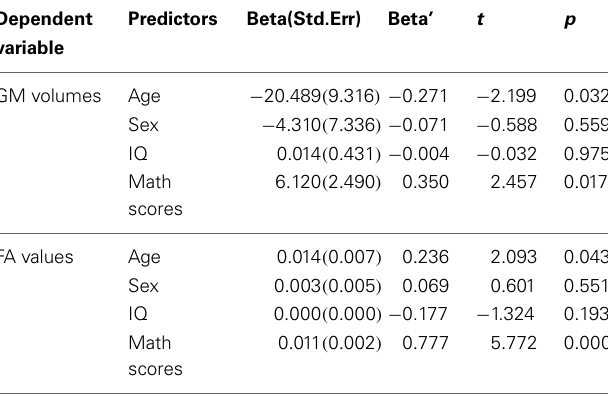
Table 2 | Coefficient of line regression